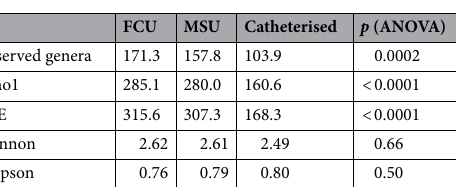
Table 2. Alpha diversity measures (mean values) for first-catch, mid-stream and catheterised urine. FCU first- catch urine, MSU mid-stream urine.